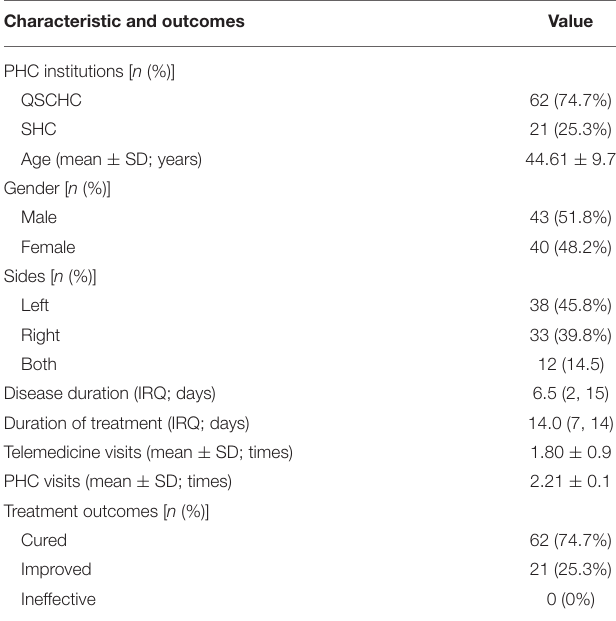
TABLE 1 | The characteristics of the patients and the outcomes of the treatment ( n = 83). Characteristic and